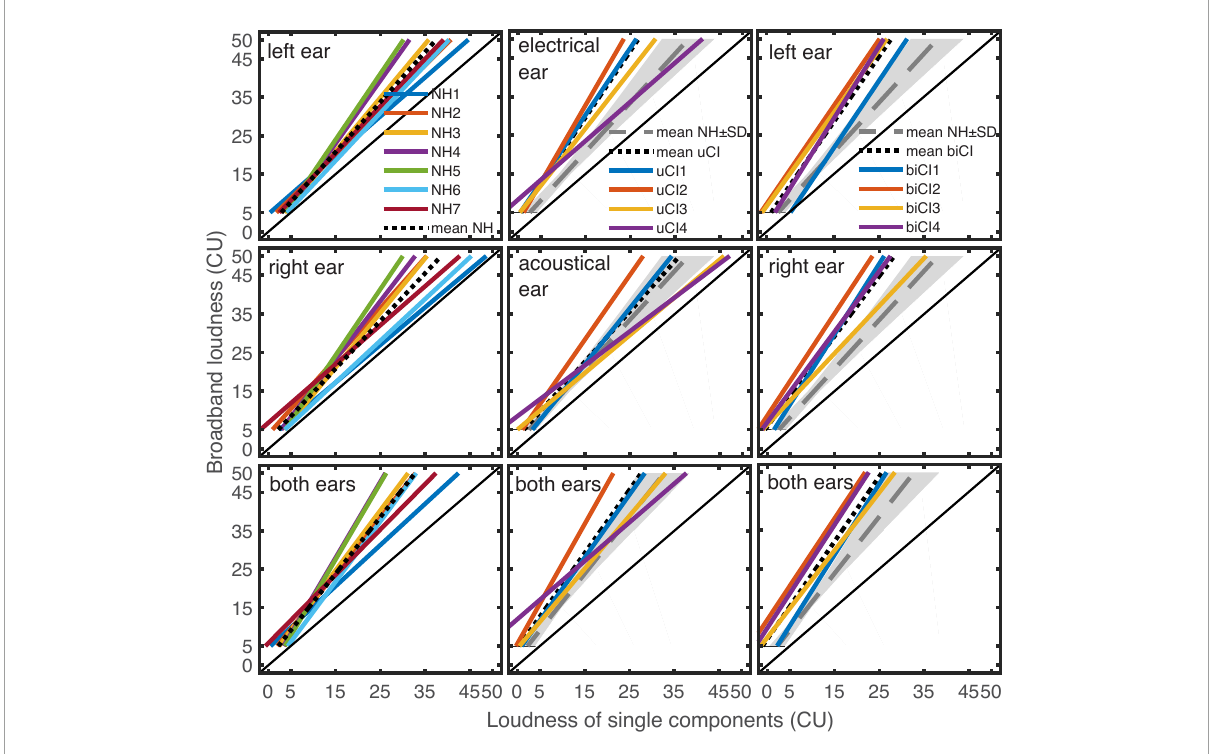
FIGURE5 Regression lines between the loudness ratings of the monaural left, monaural right, and the binaural ECLN presentation (top to bottom) and the loudness of the single narrowband components for the seven NH listeners (left column), four uCI (middle column) and the four biCI listeners (right column). The dotted lines indicate the mean regression lines. The gray lines and areas indicate the averaged NH reference ± standard deviation (SD).